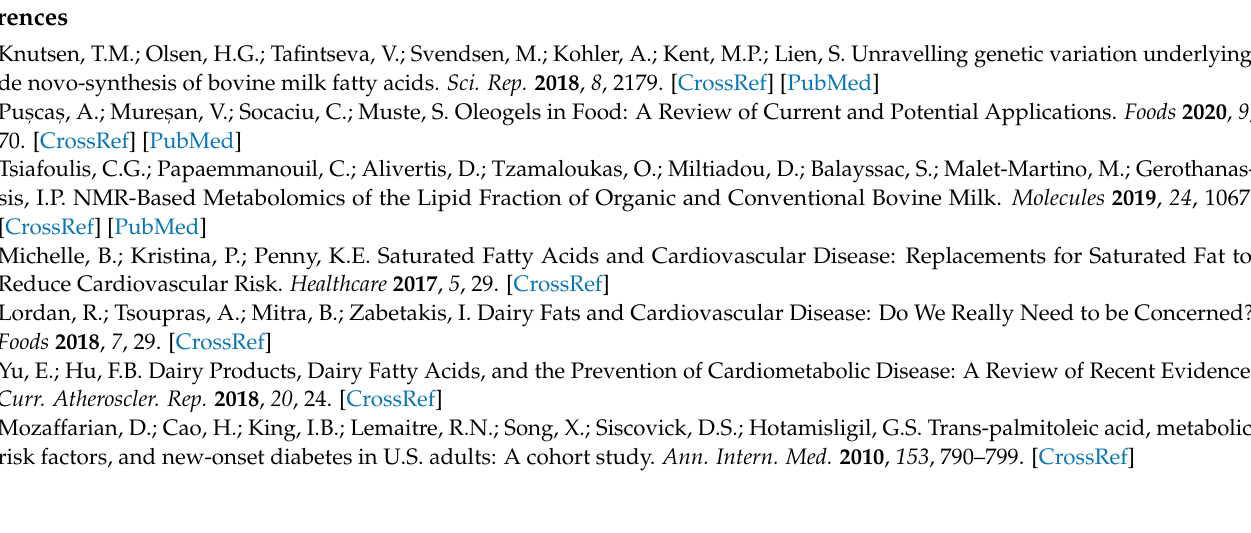
The primers used for qRT-PCR to validate the Small RNA sequencing. Table S3. The primers used for qRT-PCR to validate the RNA sequencing. Table S4. The sequences to alter miR-193a-5p and FADS1 expression in BMECs. Table S5. The primers used for qRT-PCR to detect miR-193a-5p expression in BMECs. Table S6. The primers used for qRT-PCR to detect the expression of FADS1 and other genes related to fatty acid metabolism in BMECs. Table S7. A primer containing the miR-193a-5p action site. Table S8. Statistics of miRNA sequencing reads. Table S9. Statistics of mRNA sequencing reads. Table S10. Verification results of Small RNA sequencing by qRT-PCR. Table S11. Verification results of RNA sequencing by